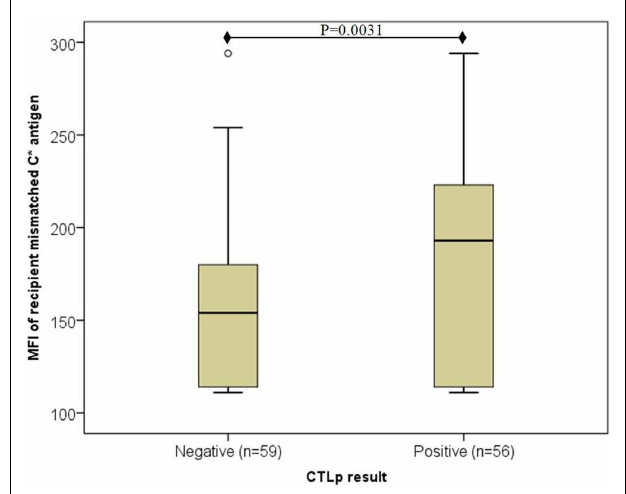
FIGURE 1 |Association of recipient mismatched C antigen cell surface expression level with CTLp result . Median MFI of recipient’s mismatched HLA-C antigen cell surface expression was significantly lower among CTLp negative compared to CTLp positive pairs ( p = 0.0031, MWU test). Horizontal line represents median MFI, box plot represents MFI values between the 25th and 75th percentiles, and thin whiskers represent